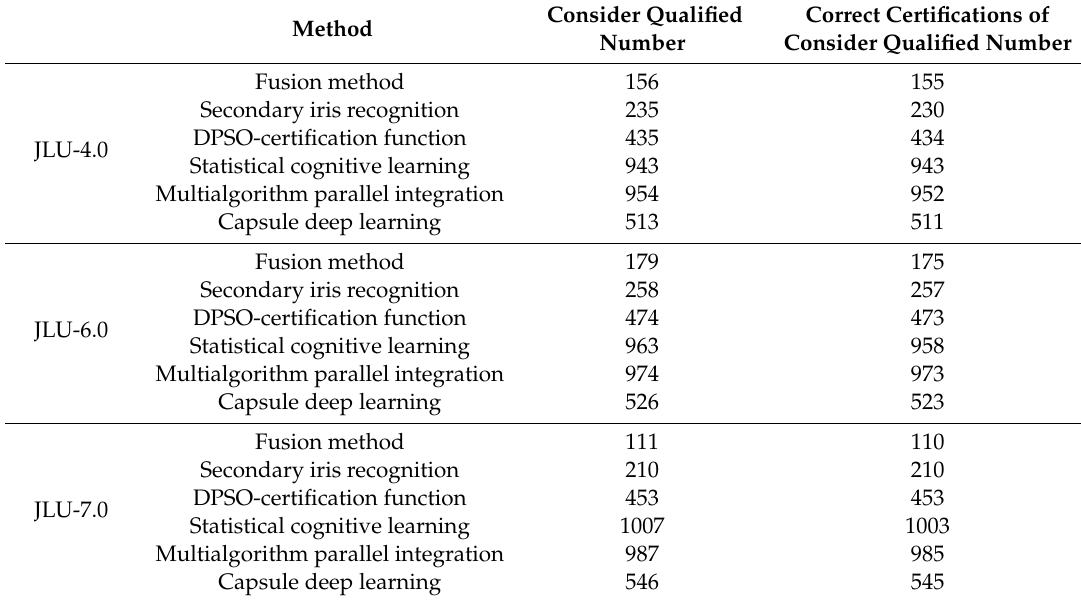
Table 3. The qualifications and certifications of the six methods.